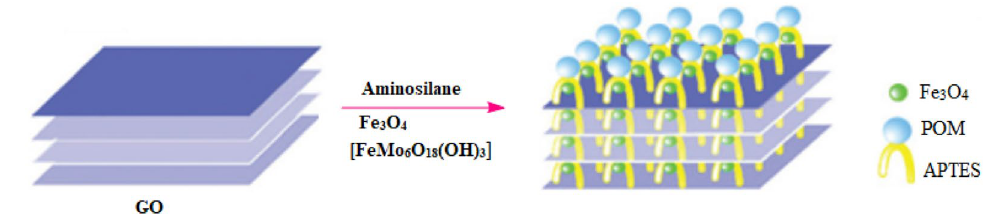
Figure 1. Synthetic route to the Fe 3 O 4 /GO/[FeMo 6 ] hybrid